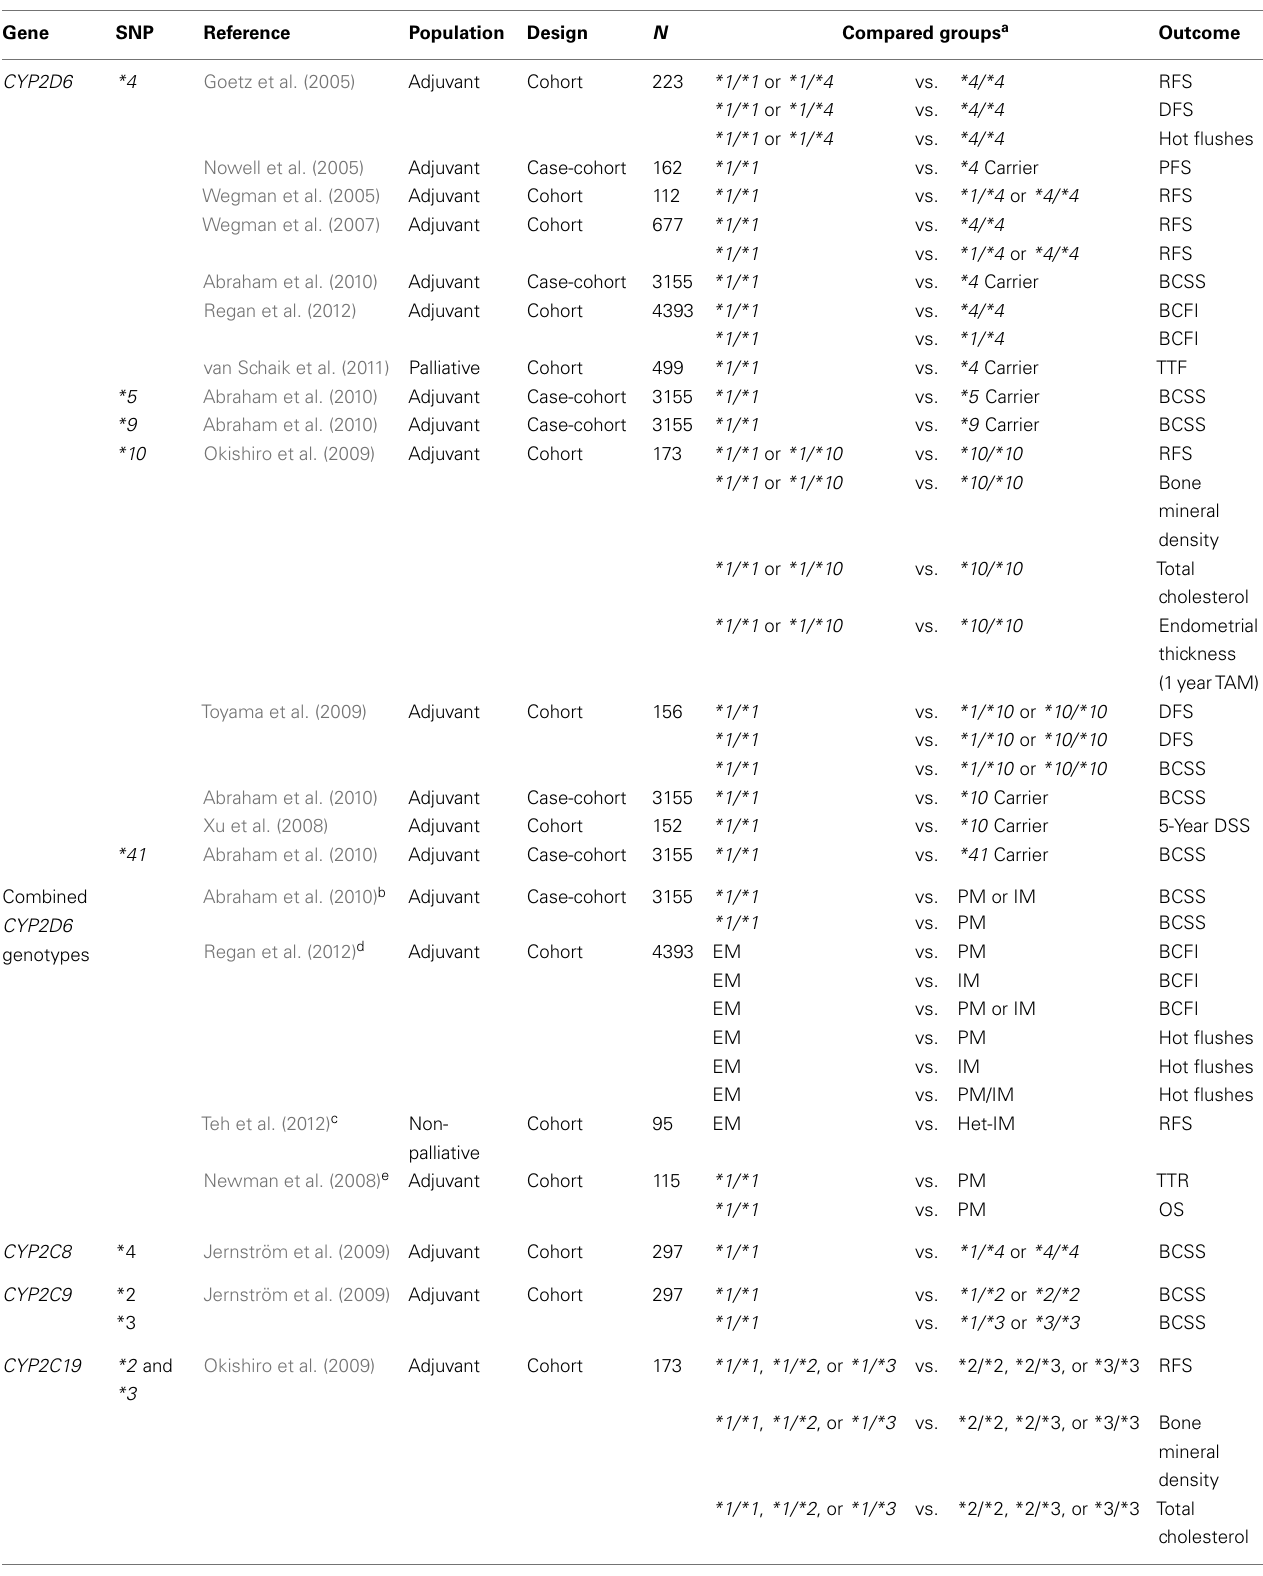
Table 2 | Null associations between polymorphisms in xenobiotic metabolizing enzymes and breast cancer outcomes after tamoxifen treatment. Gene